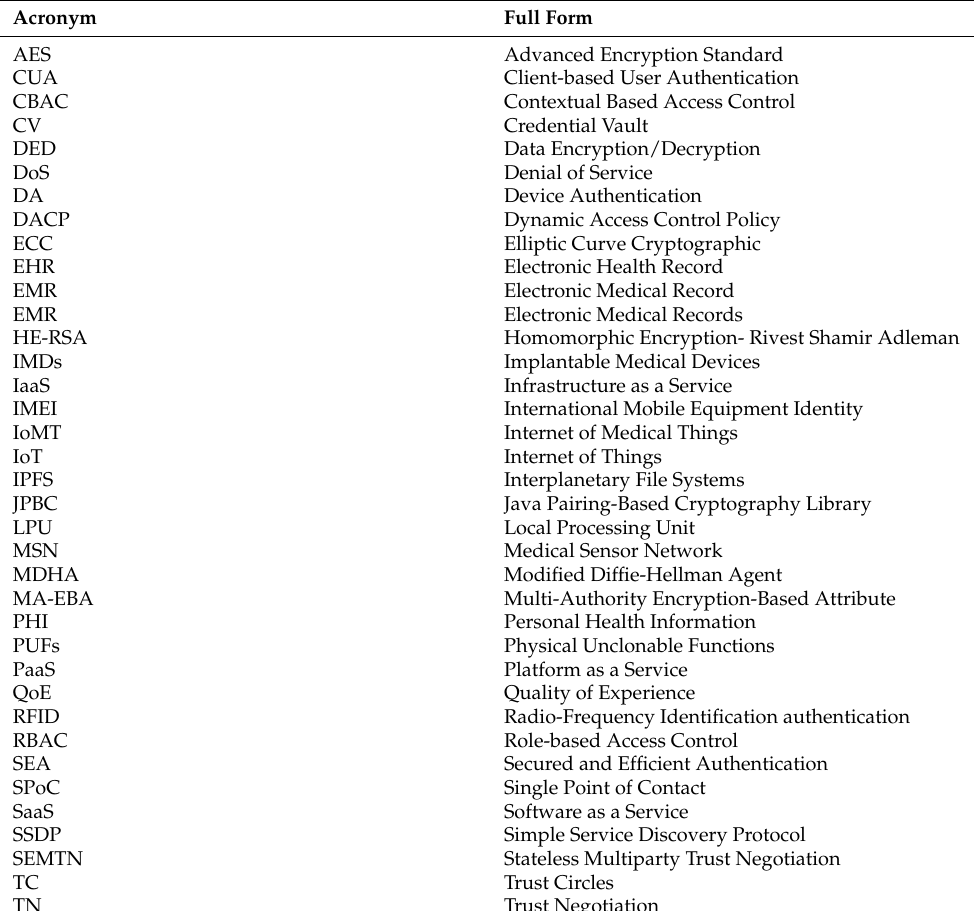
Table 1. Acronyms and their respective full